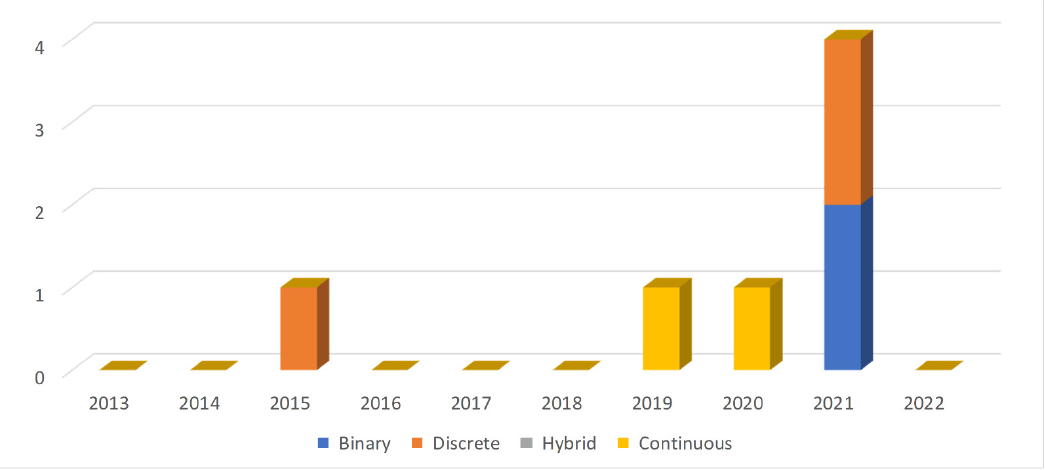
Figure 7. Distribution of works on independent zones by Tier 2 category.